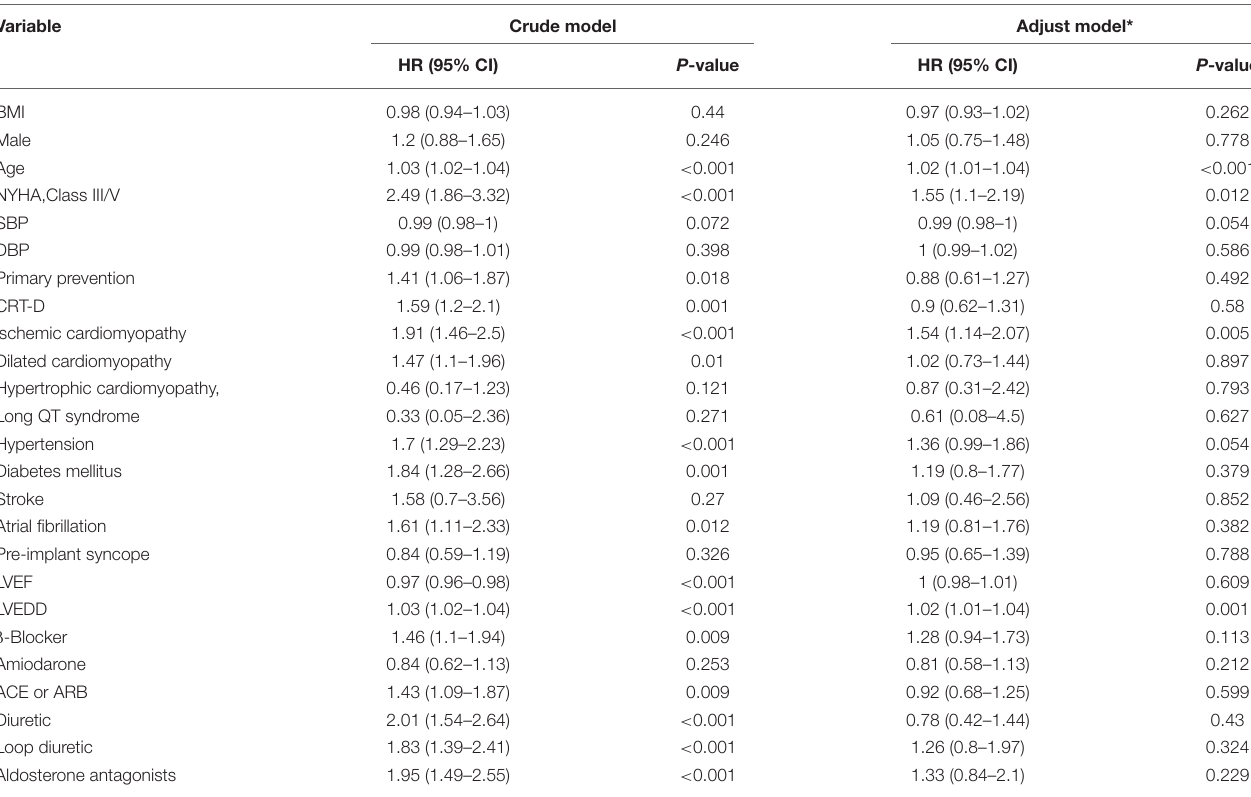
TABLE 3 | The univariate and multivariate risk factors of all-cause